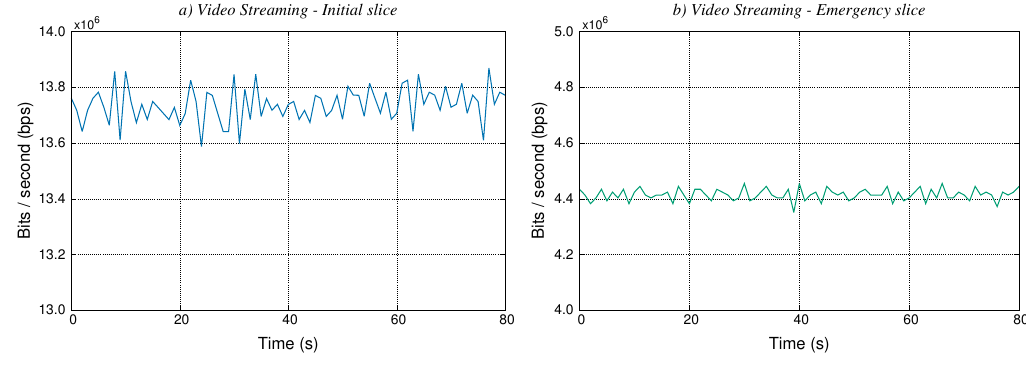
Figure 8. Traffic flows of the video